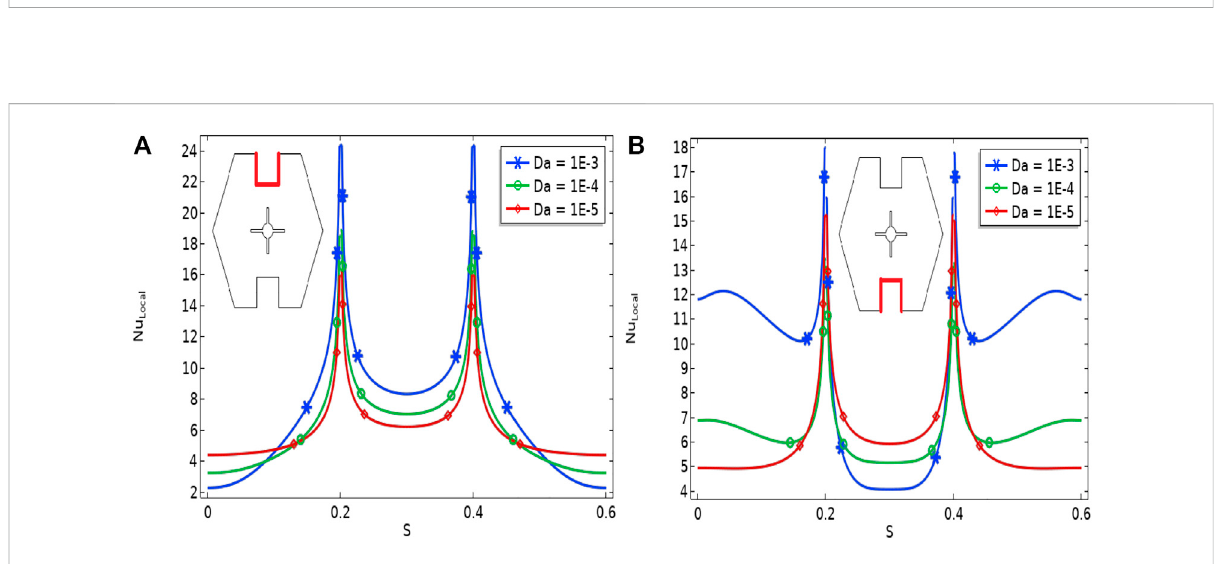
FIGURE 7 (A,B) Local Nusselt number against